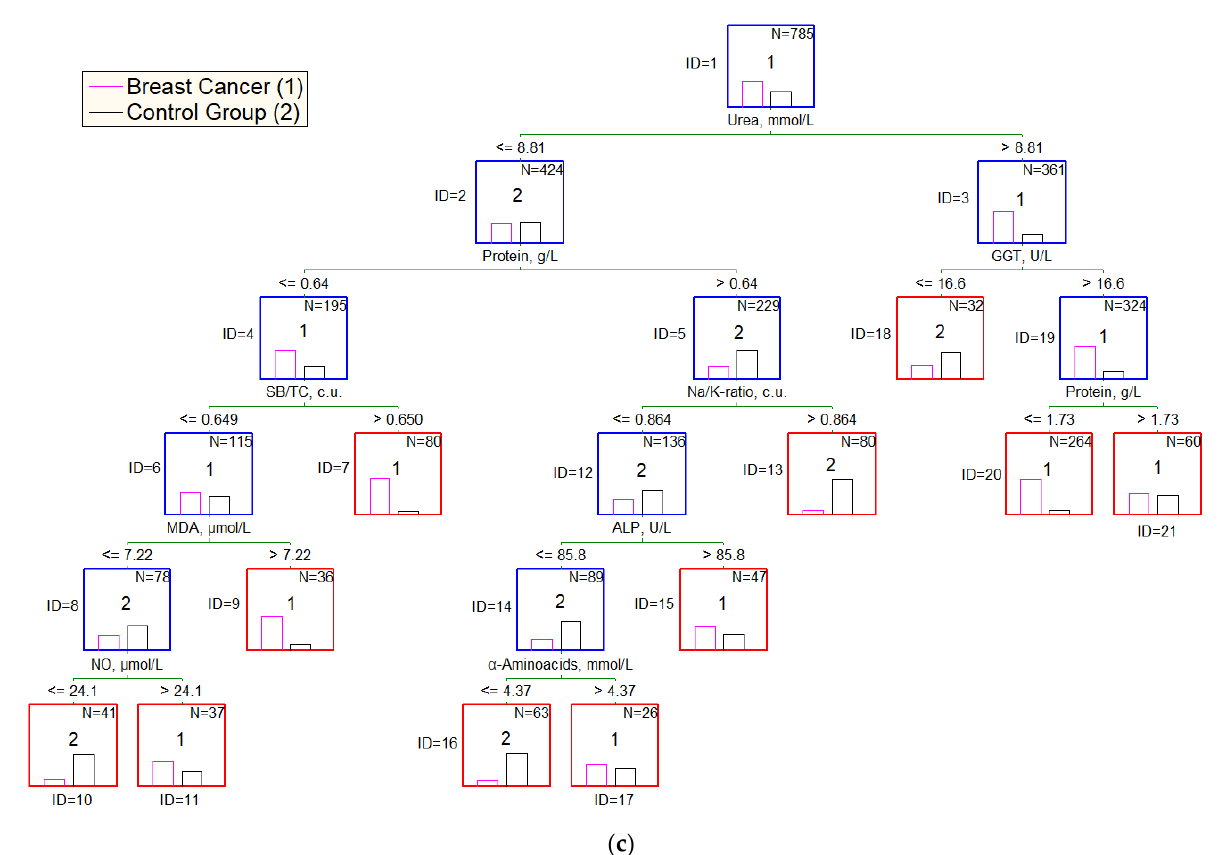
Figure 1. ( a ) PCA Factor plane for two groups (BC and Control); ( b ) — ROC curve for random forest method; ( c ) — Tree graph. Num. of non-terminal nodes — 10, num. of terminal nodes — 11. Model: